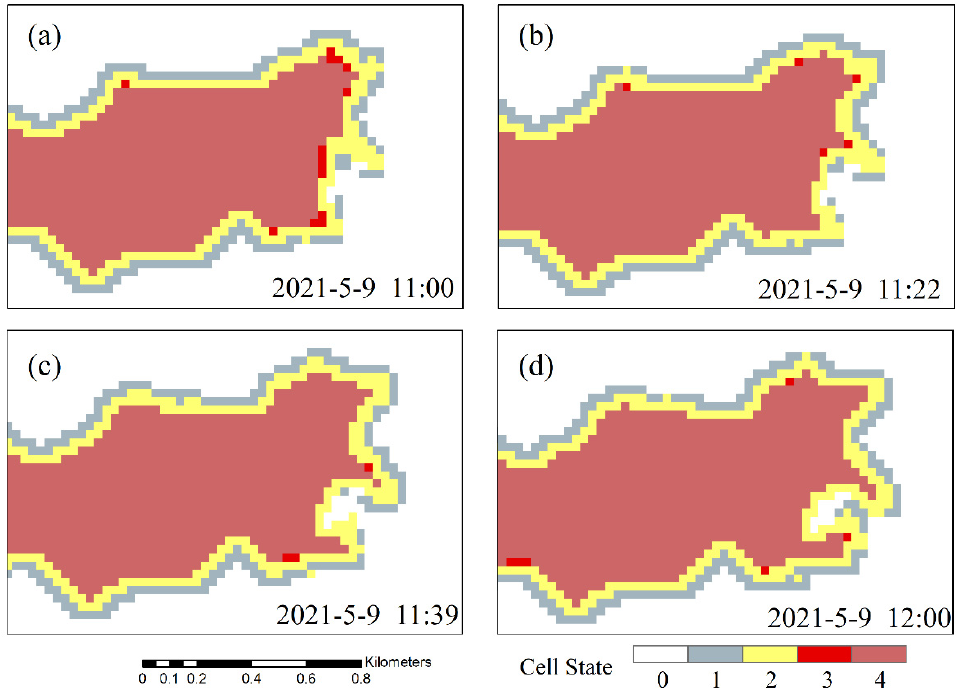
Figure 7. Predicted forest fire spread simulation map for 2021.5.9 11:00–12:00: ( a ) traditional CA model simulation graph for 9 May 2021, at 11:00; ( b ) adaptive CA model simulation graph for 9 May 2021, at 11:22; ( c ) adaptive CA model simulation graph for 9 May 2021, at 11:39; ( d ) traditional CA model simulation graph for 9 May 2021, at 12:00.